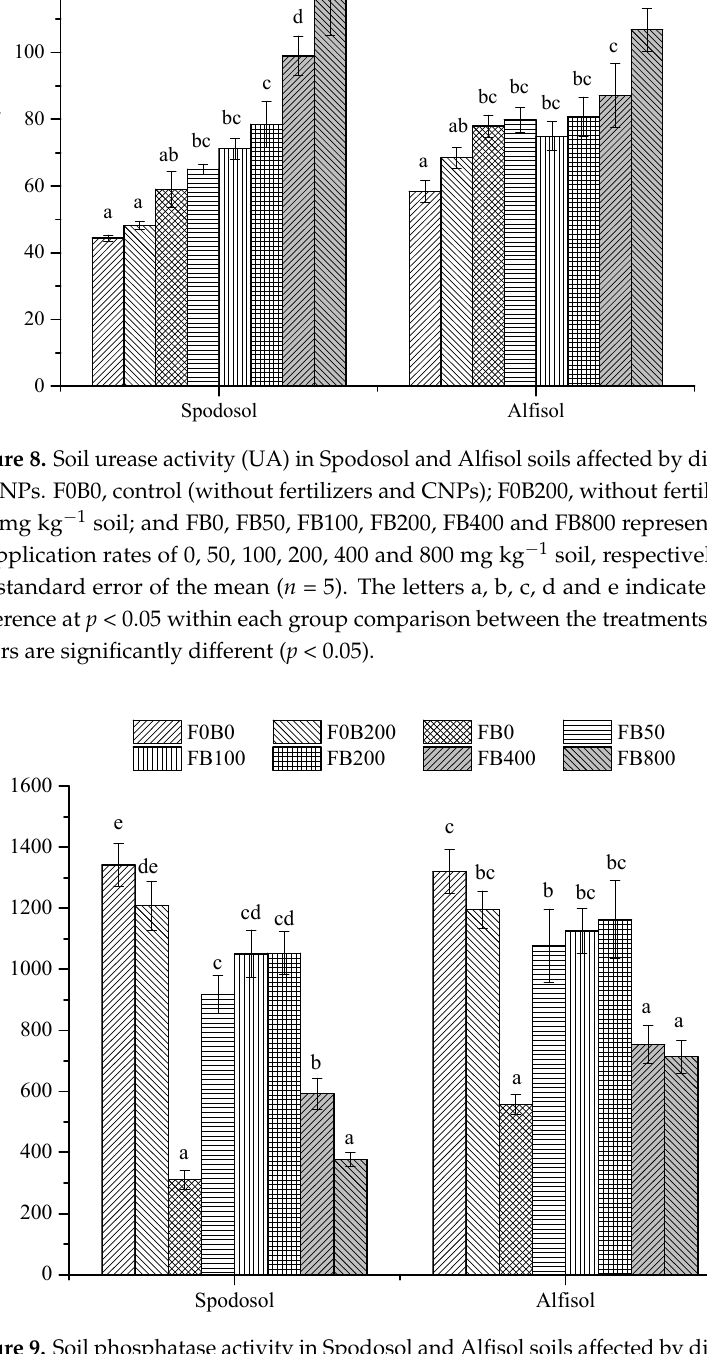
Figure 9. Soil phosphatase activity in Spodosol and Alfisol soils affected by different application rates of CNPs. F0B0, control (without fertilizers and CNPs); F0B200, without fertilizers and with CNPs at 200 mg kg − 1 soil; and FB0, FB50, FB100, FB200, FB400 and FB800 represent those with and CNPs at application rates of 0, 50, 100, 200, 400 and 800 mg kg − 1 soil, respectively. Error bars represent the standard error of the mean ( n = 5). The letters a, b, c, d and e indicate statistically significant difference at p < 0.05 within each group comparison between the treatments. Bars with no common letters are significantly different ( p < 0.05).